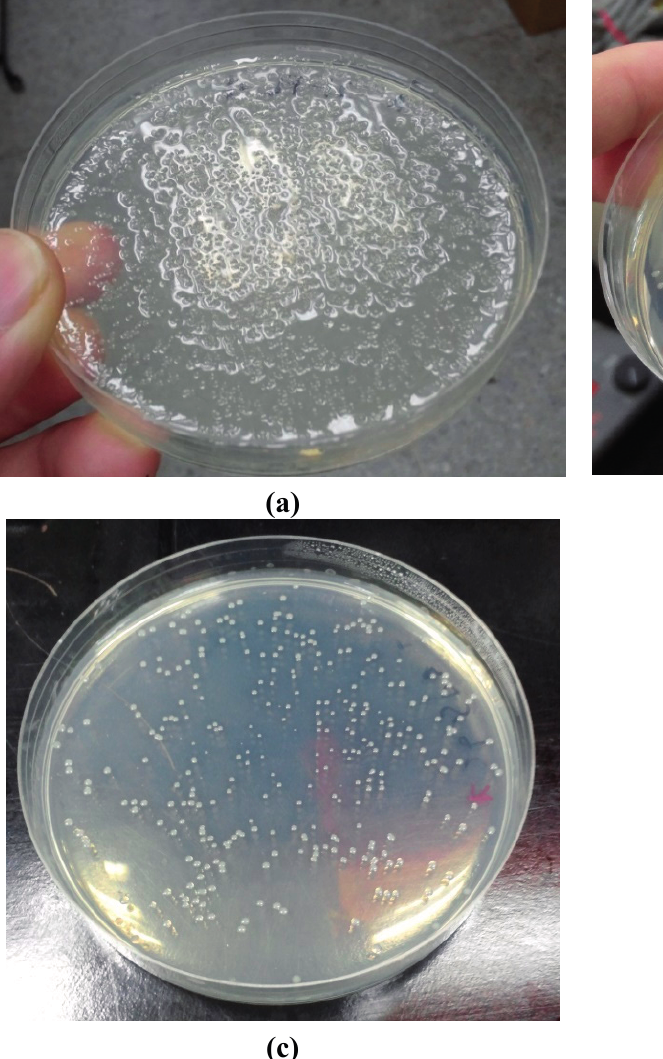
Figure 2. The agar plates grown with E. coli harboring ( a ) pET-AgaA-FL ( b ) pET-AgaA- Δ SP and ( c ) pET-AgaA-PelB. E. coli cells harboring the three different plasmids, individually, were plated out onto Luria-Bertani (LB) agar plates and incubated at 37 °C for 12